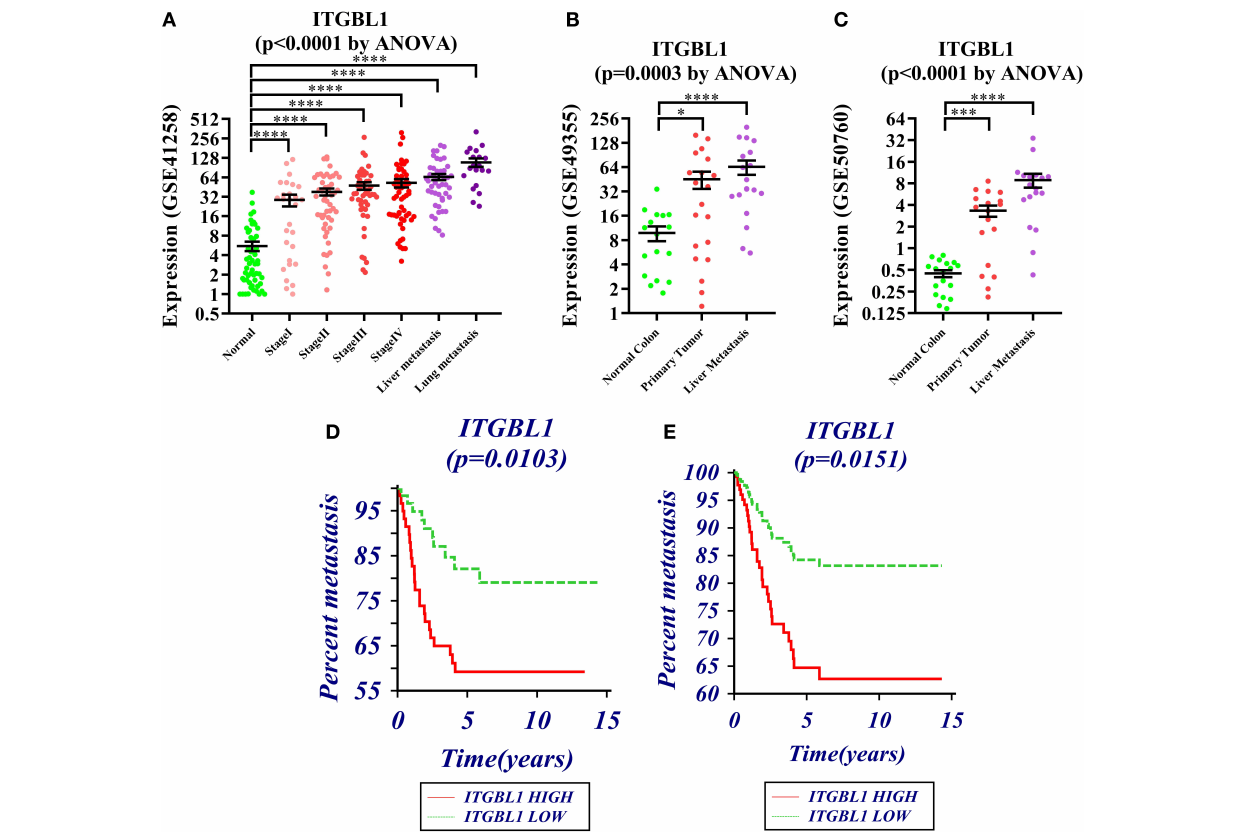
FIGURE 1 | (A–C) Expression changes of ITGBL1 in the development and metastasis of colorectal cancer (CRC) (* P < 0.05, ** P < 0.01, *** P < 0.001, **** P < 0.0001). (D) Survival curve of ITGBL1 and the metastasis time of CRC patients (Kaplan–Meier survival estimate and univariable survival analysis model). (E) Survival curve of ITGBL1 and the metastasis time of CRC patients (Cox proportional hazards regression model and multivariate analysis model, excluding the influence of tumor stages and ages on metastasis time).